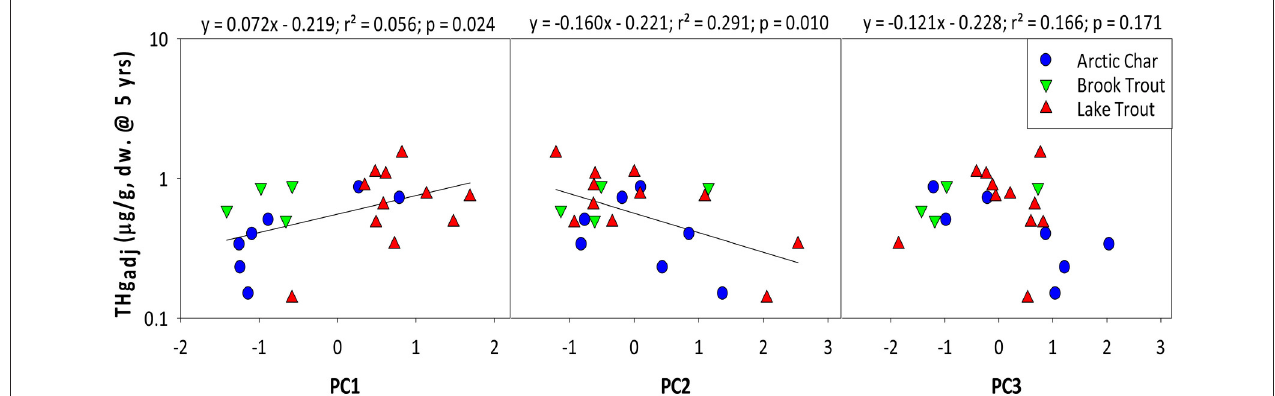
FIGURE 2 | Relationships between age-adjusted THg concentrations (5 years) in salmonids and principal components as shown in Table 6. Brook Trout data are from the current study whereas Arctic Char and Lake Trout data are from Lescord et al. (2015) and Kidd et al. (2012), respectively.